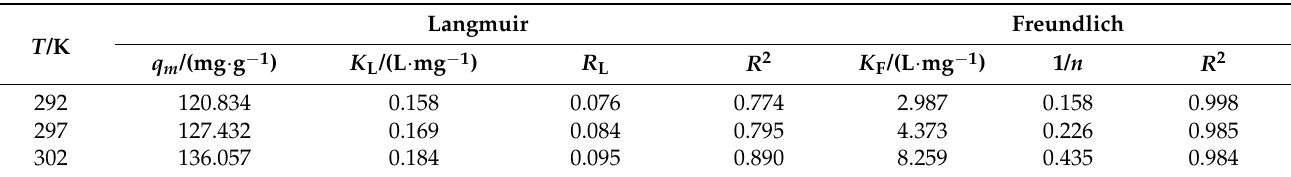
Table 2. Isotherm fitting results.